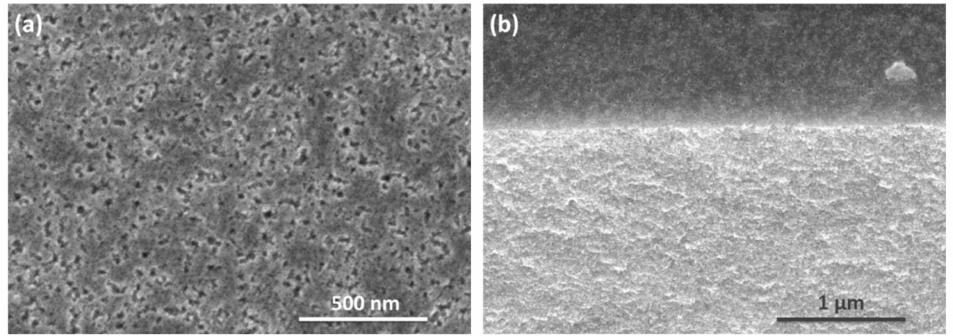
Figure 1. SEM top view ( a ) and a cross-sectional view and ( b ) of the por-Si